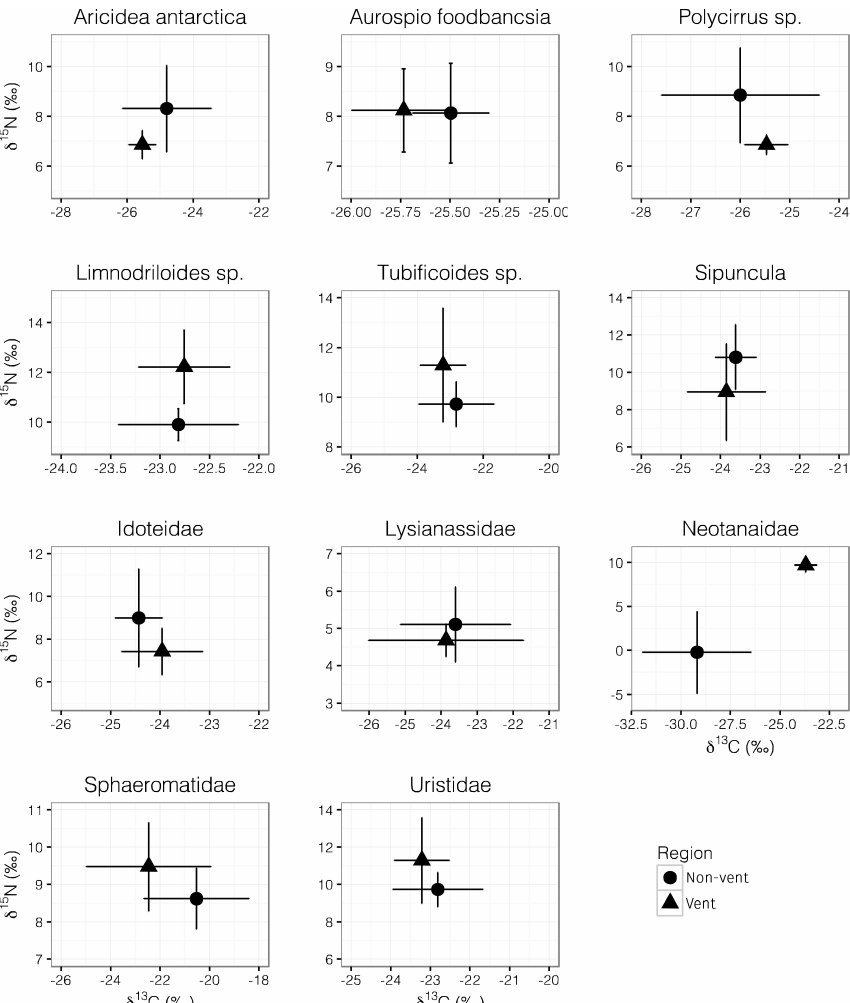
Figure 5. Biplot of CN isotopic data from species sampled at both hydrothermal sites and non-hydrothermal background regions. Mean ± standard deviation, X – Y scales